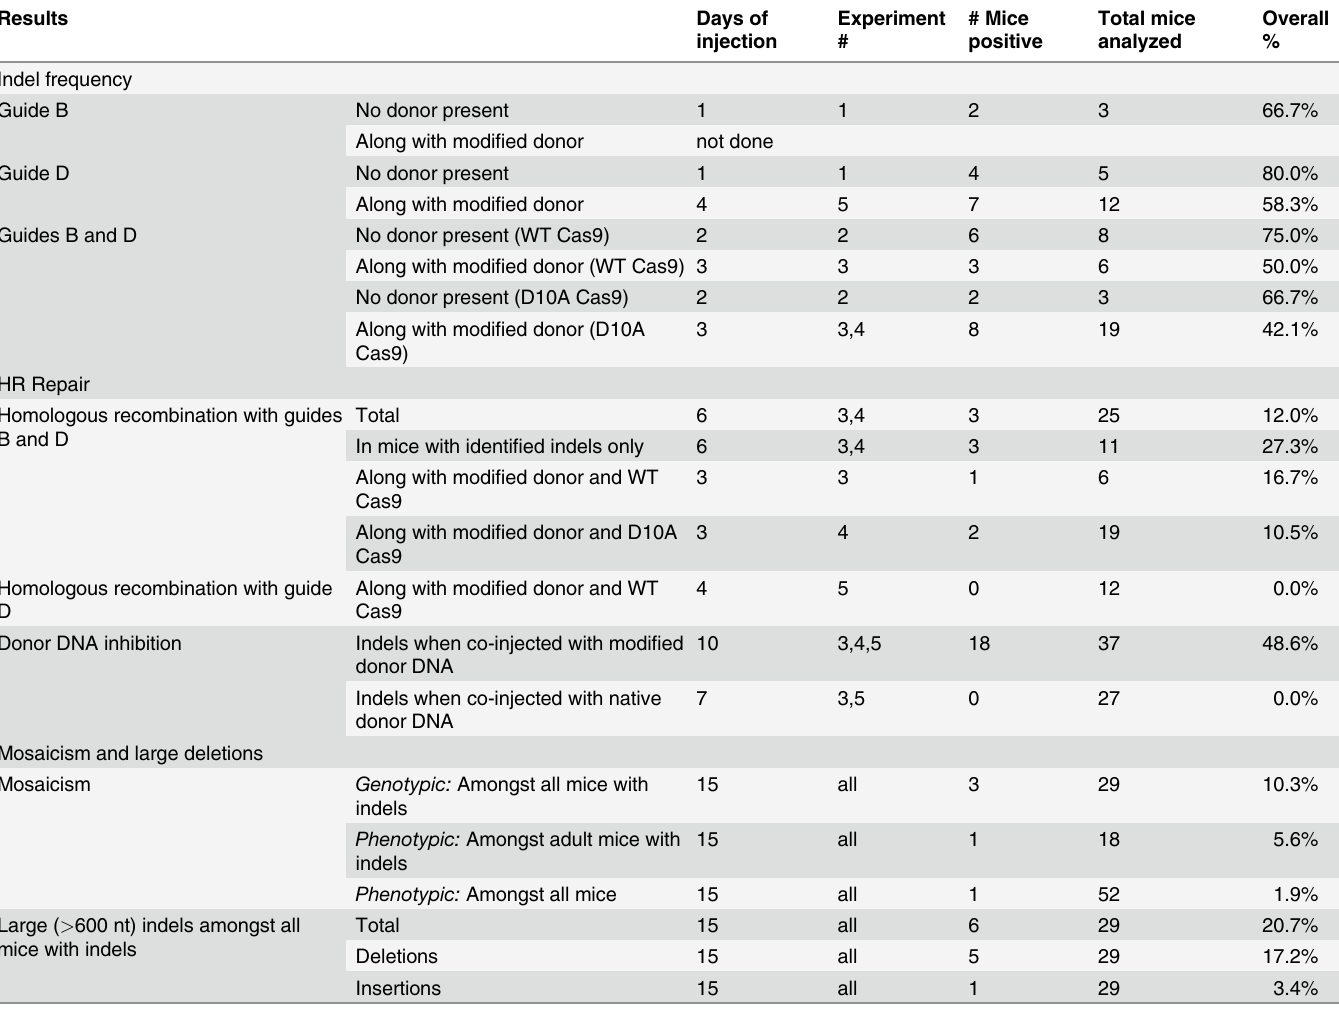
Table 2. Summary of all Cas9-mediated genome editing